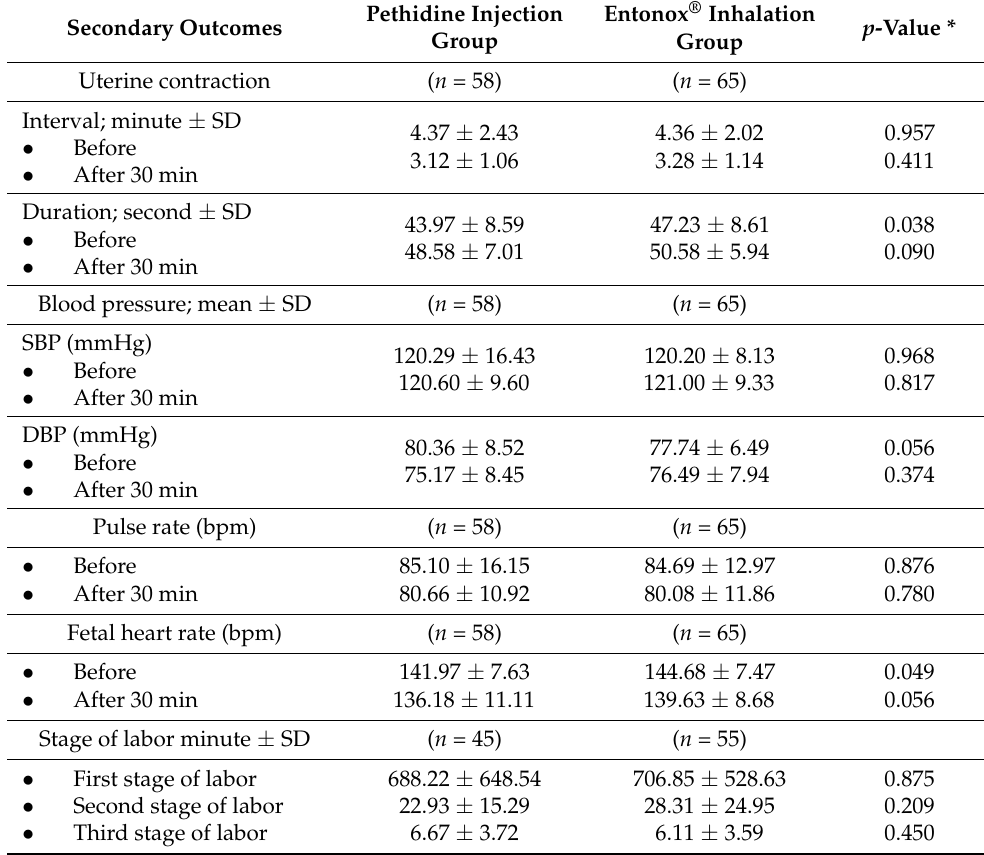
Table 6. Comparisons of other secondary outcomes in pethidine group and Entonox ®